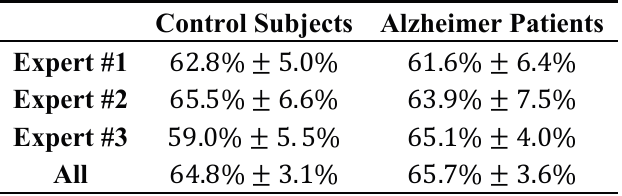
Table 3. Automatic detection of artifacts sources versus clean sources (multilayer perceptron with 2-fold cross-validation) for each expert considered independently and aggregated together. Classification was performed for sources from the group of 17 patients suffering from Alzheimer’s disease, and for sources from the group of 24 control subjects. Rows indicate the classification rate average and standard deviation on 1000 classification attempts.